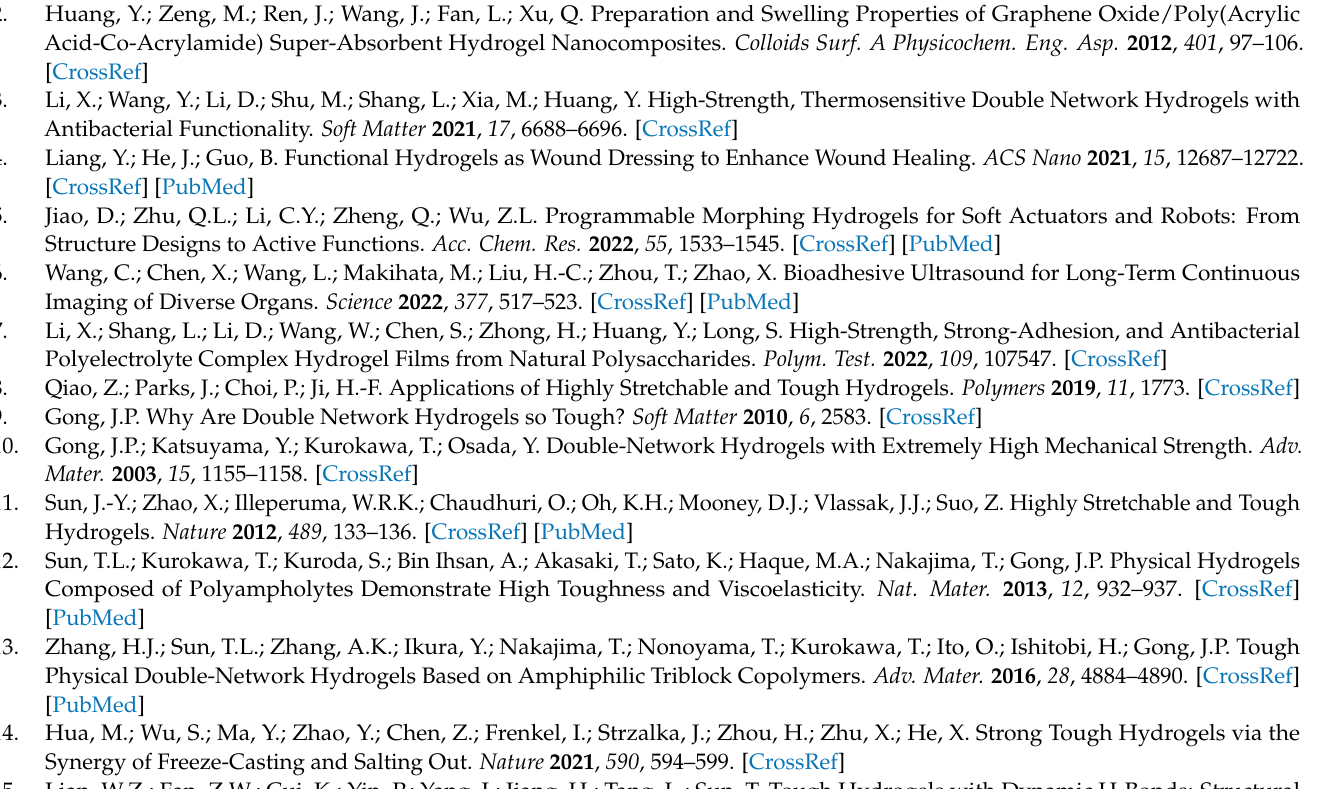
Table S1: Summary of tensile properties of PA/CF composite hydrogels with different sample widths shown in Figure S4; Table S2: Summary of tensile properties of representative hydrogel samples shown in Figure 1c–e; Table S3: Summary of adhesion strength of PA/CF-6 composite hydrogels to diverse substrates shown in Figure